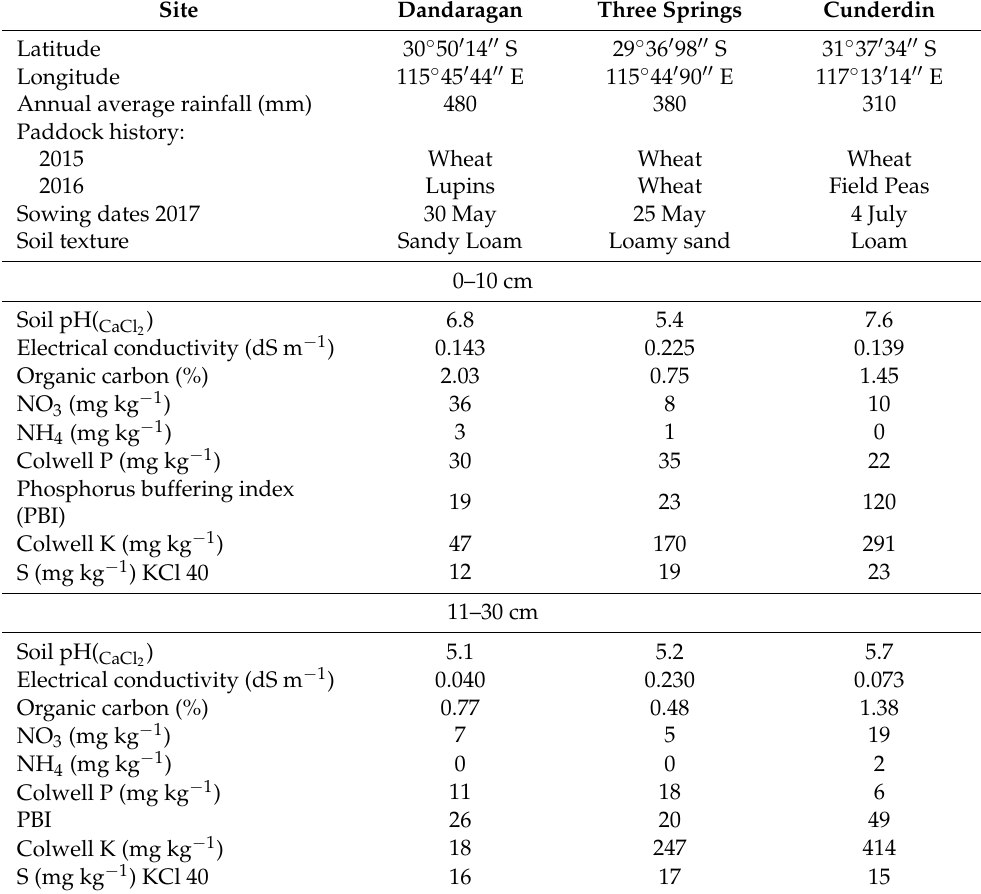
Table 1. Site location, characterisation and soil analysis for Dandaragan, Three Springs and Cunderdin field sites.